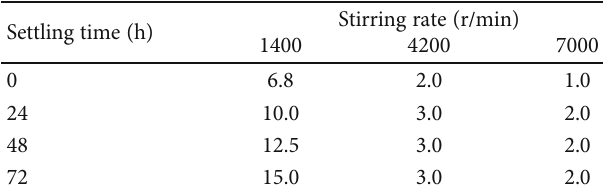
Table 4: The water release volume from the heavy oil emulsions obtained at 150 ° C and di ff erent stirring rates